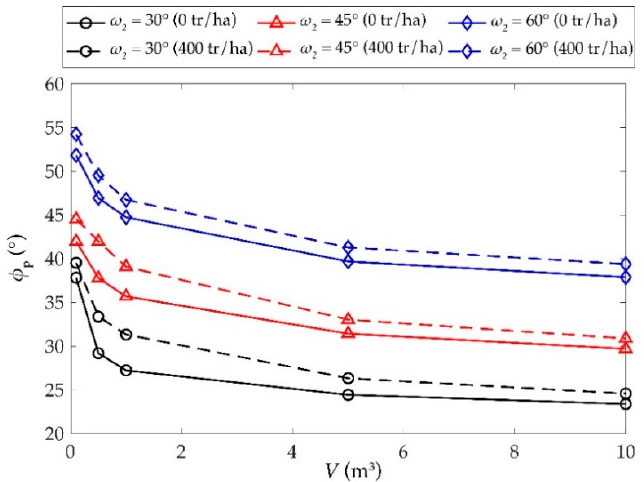
Figure 9. Results of the parametrical simulations for ( a ) 𝜔 (cid:2870) = 30°, ( b ) 45° and ( c ) 60° slopes. Energy angle values are given as a function of block volumes and forest coverage.